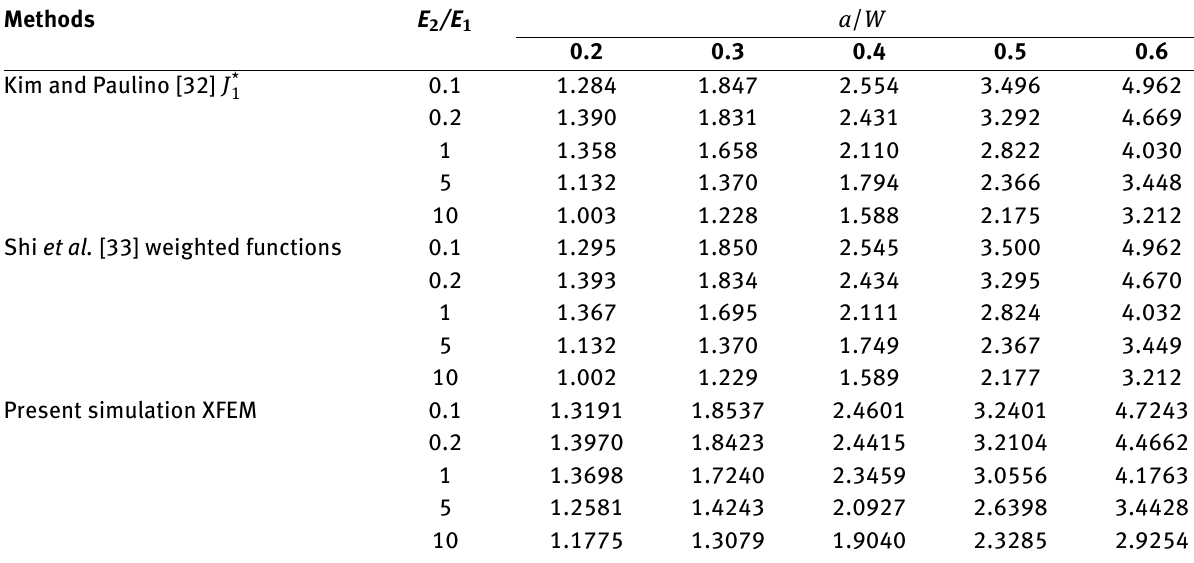
Table 1: Validation study of normalized first mode SIF for edge cracked plate under tensile loading for different values of modulus ratio Methods Kim and Paulino [32] J * 1